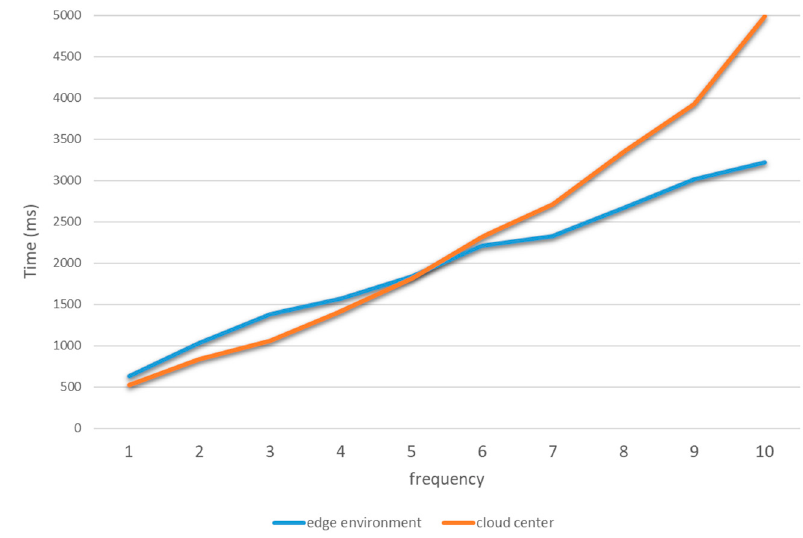
Figure 11. Average time consumption of multi-node cooperative experiment .